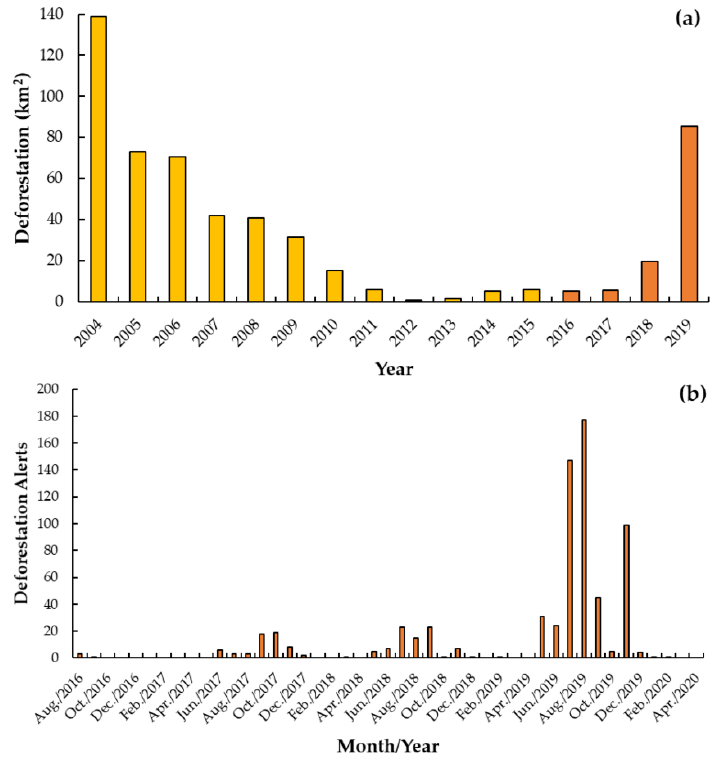
Figure 3. ( a ) Annual deforestation rates in the Apyterewa Indigenous Land since the initiation of anti-deforestation measures in the Brazilian Amazon estimated by the Brazilian National Institute for Space Research (INPE) [21] (orange bars represent the period spanning the LULC mappings (2016–2019)), and ( b ) monthly total deforestation alerts in the Apyterewa Indigenous Land estimated by INPE [21]. Although INPE [21] provides this information since 2015, the first alert detected in the study area occurred in August 2016.